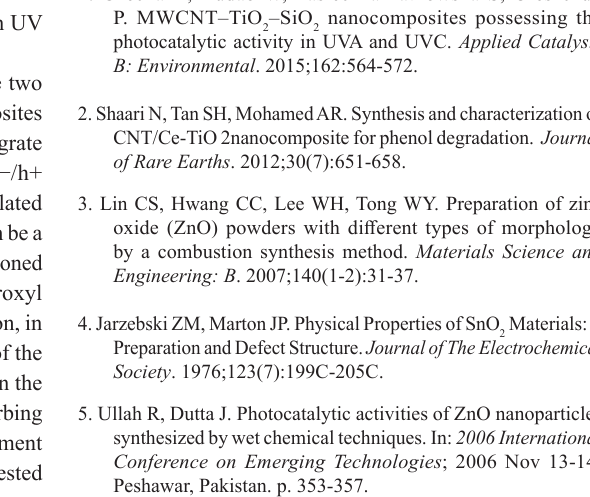
Figure 4: Activity photocatalytic of the nanocomposites on the decrease of the methyl orange dye concentration in solution. to exhibit higher efficiency and better enhancement in UV light decomposition, compared to other